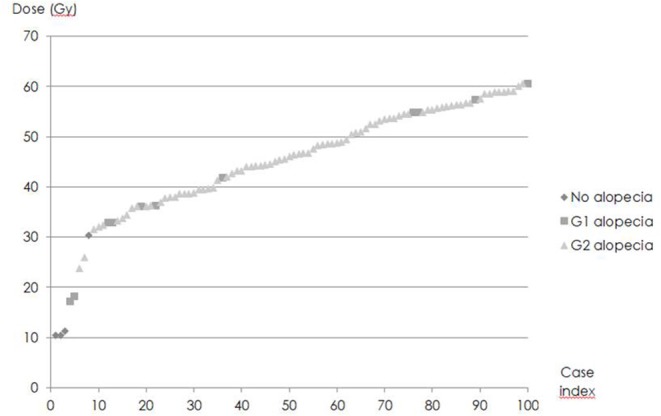
Distribution of Maximum dose (D0,1cc) in the series and grade of acute alopecia.